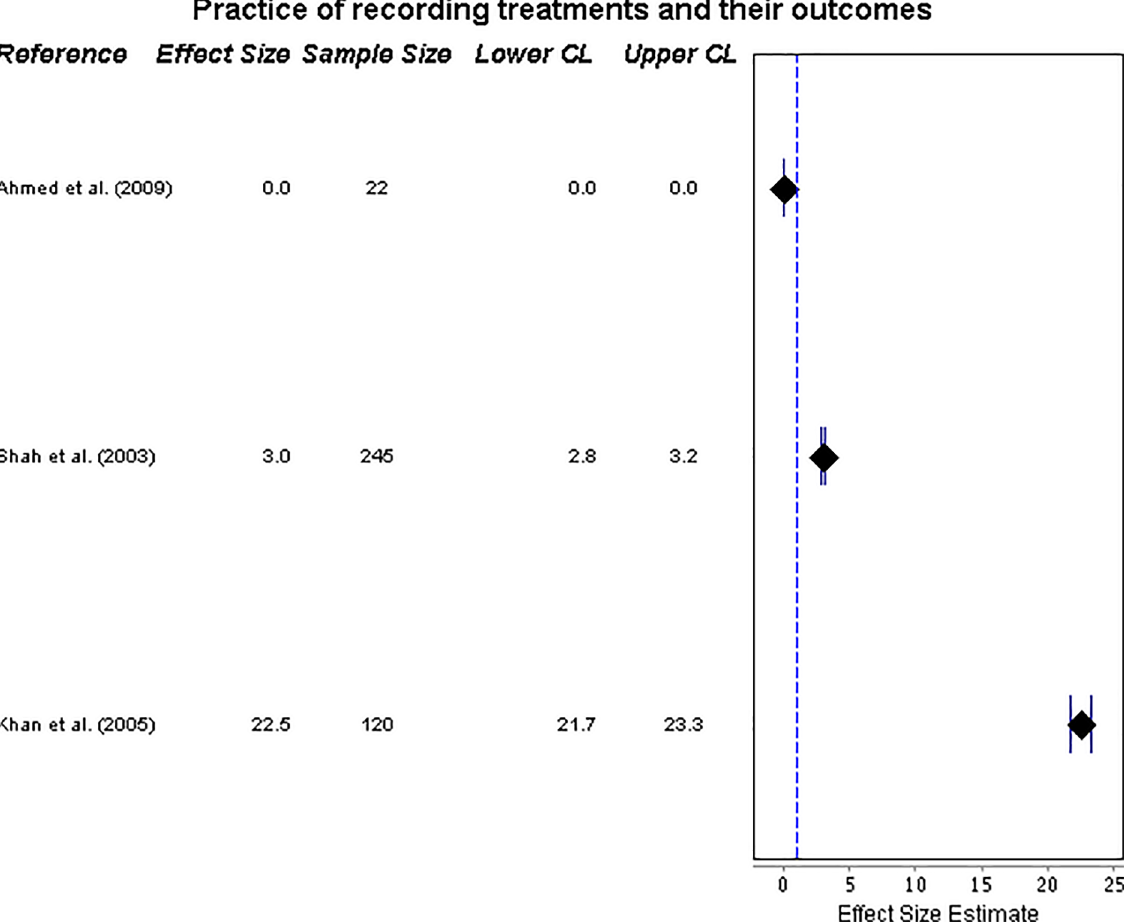
Fig 7. Forest plot on recording treatments. Forest plot visualising data on practitioners’ practice of recording treatments and their outcomes (ISTC Standard 13). CL = 95% Confidence Level.